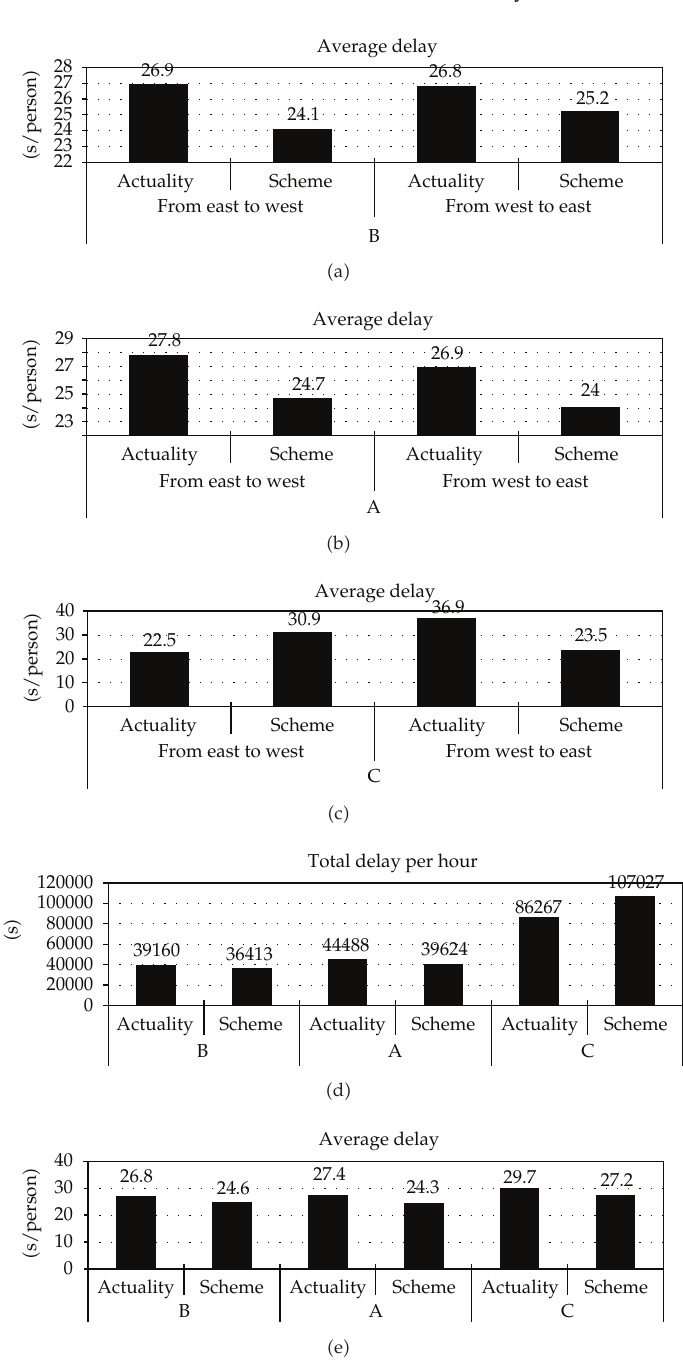
Figure 12: A comparison figure of pedestrian delays of road actuality and